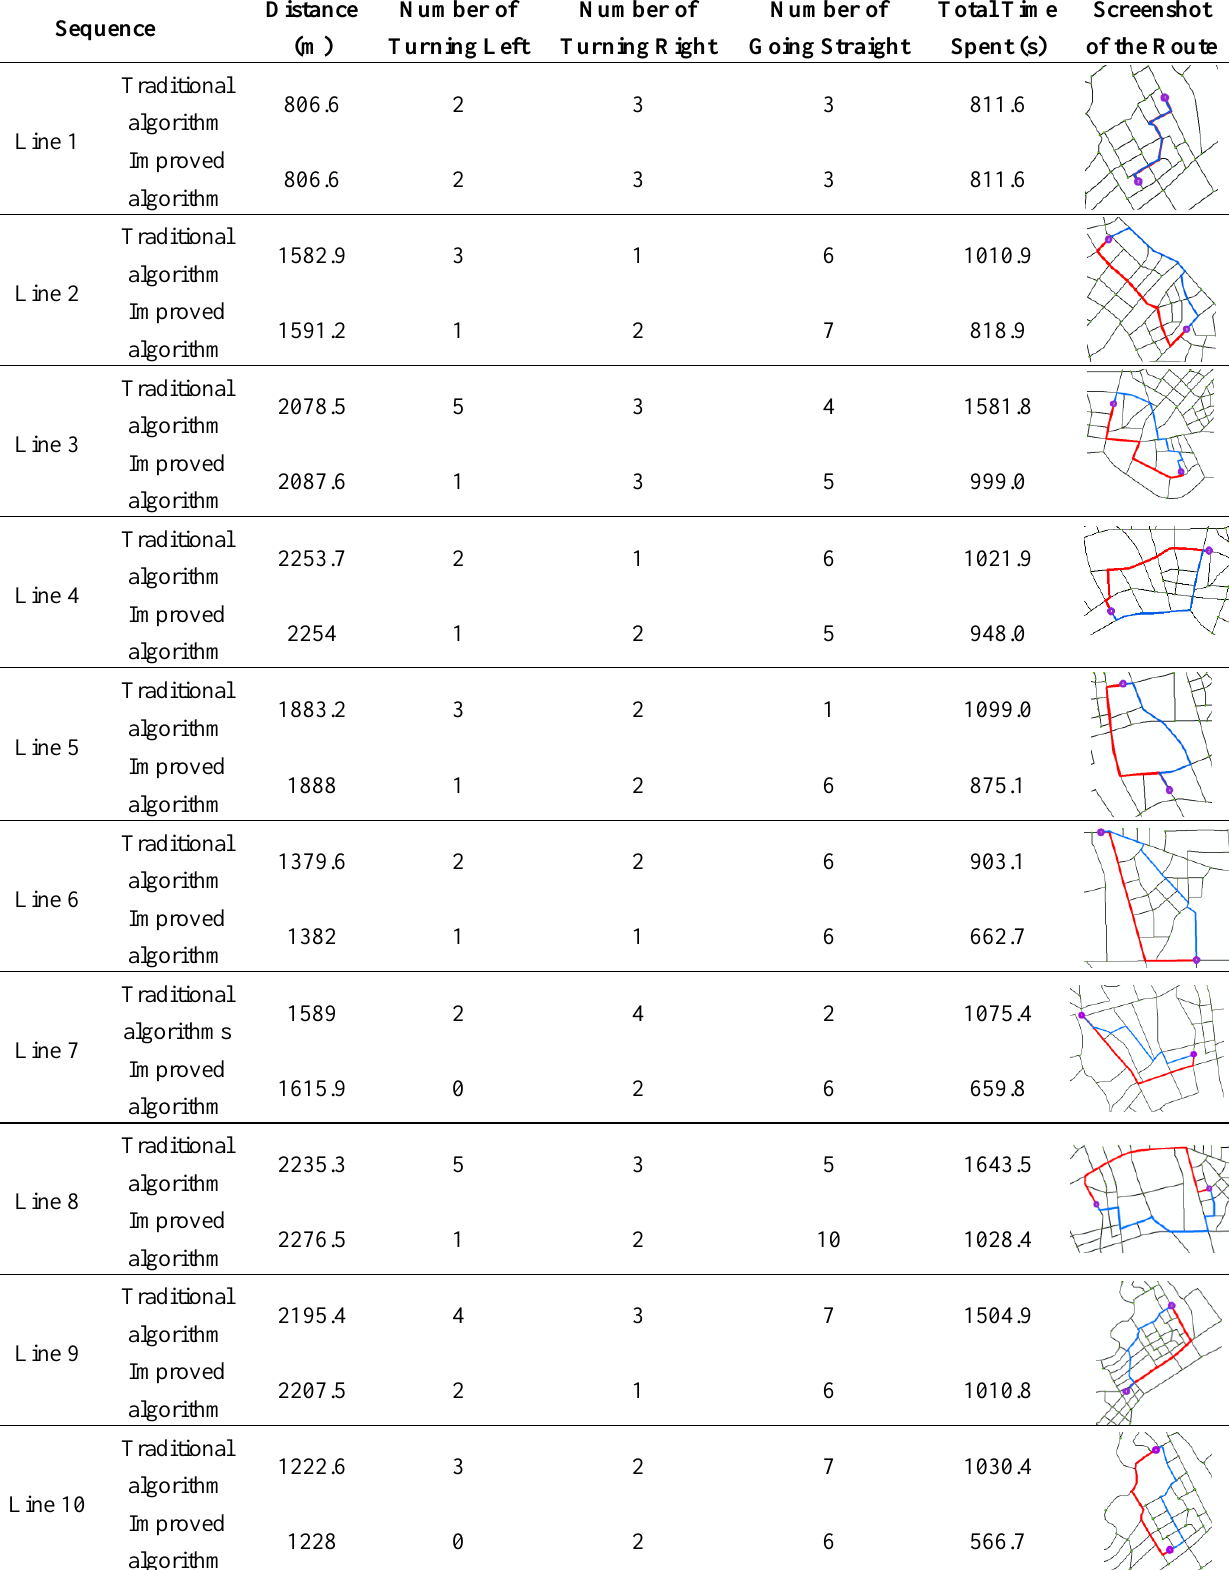
Table 3. Statistics results of the analysis of test areas that were randomly